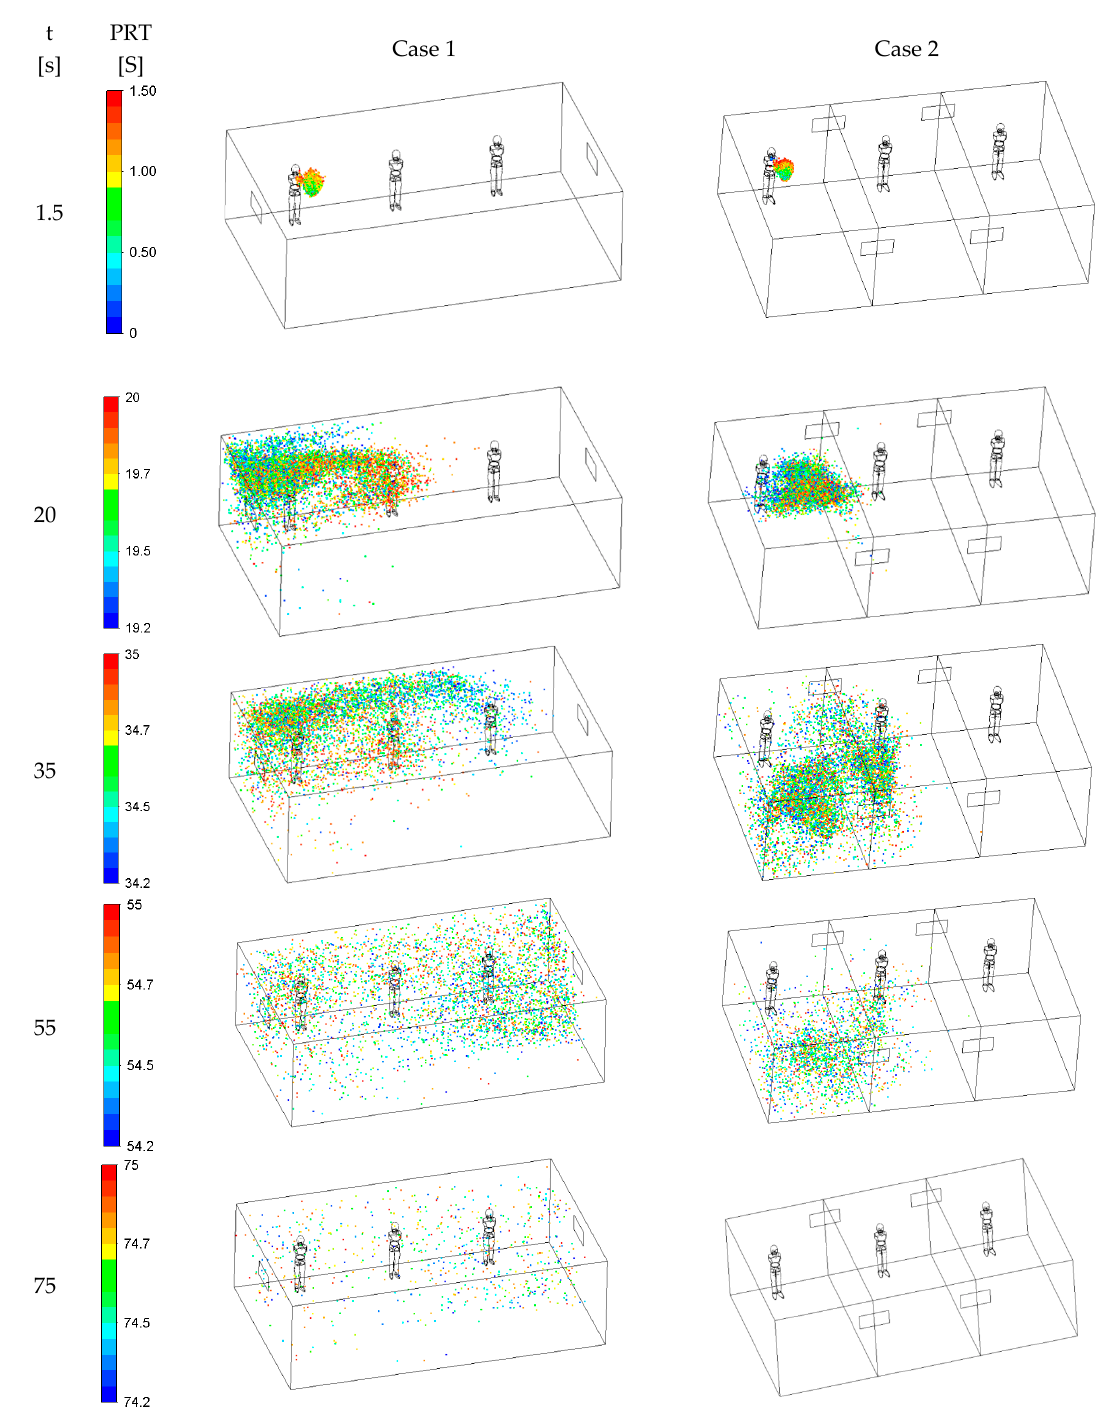
Figure 12. Particle residence time in the indoor space at different times with two ventilation systems.